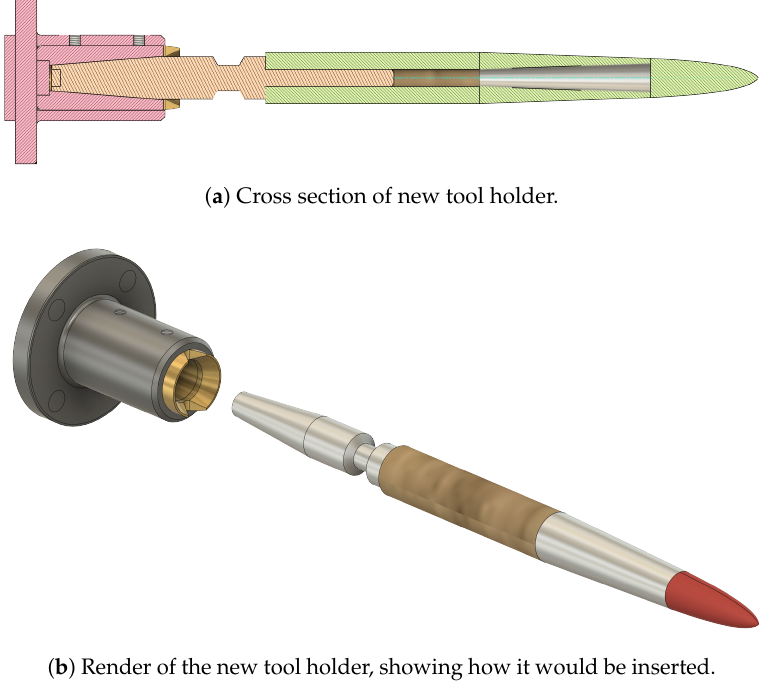
Figure 4. A render of the next iteration of the tool